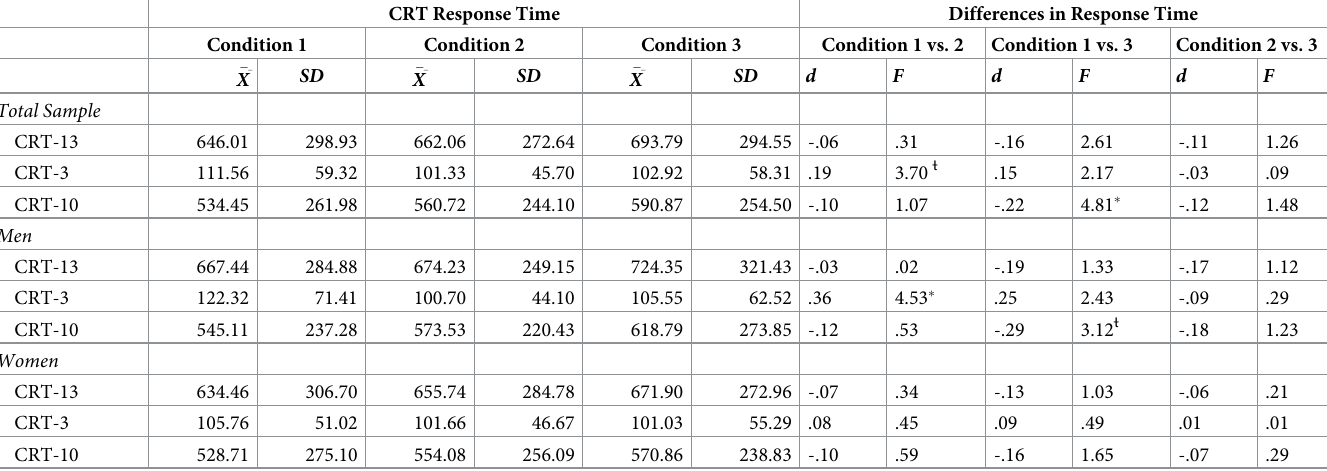
Table 4. Mean, standard deviations, and differences in CRT response time (in seconds) according to experimental